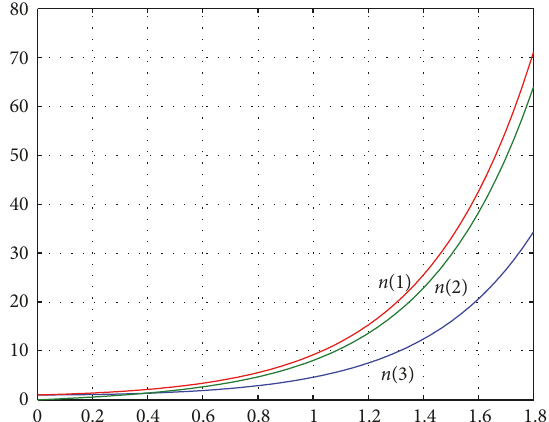
Figure 4: Evolution curve of variables when the initial state set as [0,0, 1] .